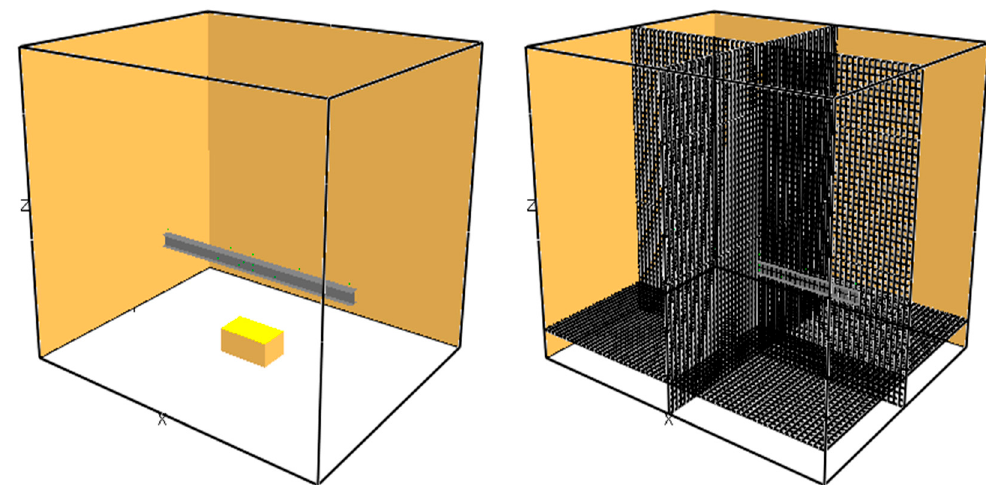
Figure 10. Extent of the Fire Dynamics Simulator model geometry ( left ) and the grid composition ( right ).